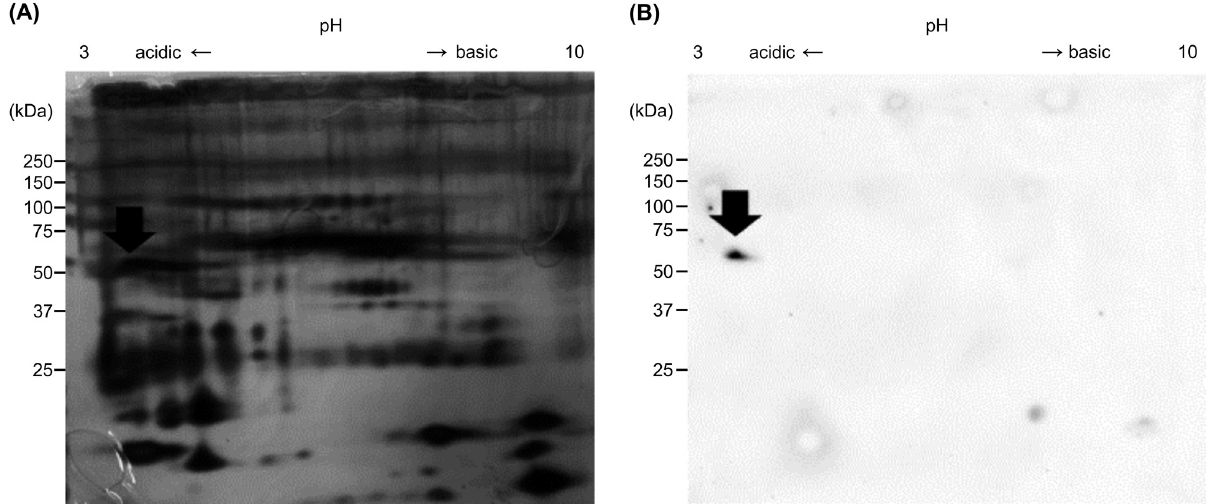
Fig 2. Two-dimensional electrophoresis of citrullinated peptides in the saliva of healthy participants. Saliva samples (200 μ g per lane) were used. A: silver stain. B: the membranes were chemically treated and immunostained using an anti-modified citrulline antibody as the primary antibody and horseradish peroxidase-labeled goat anti-rabbit IgG antibody as the secondary antibody. Arrows: the peptide was excised and subjected to matrix- assisted laser desorption/ionization time-of-flight mass spectrometry analysis.